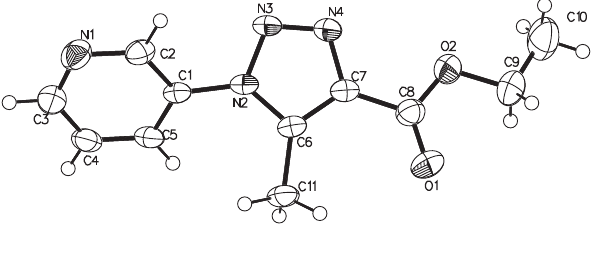
Table 1: Data collection and handling.